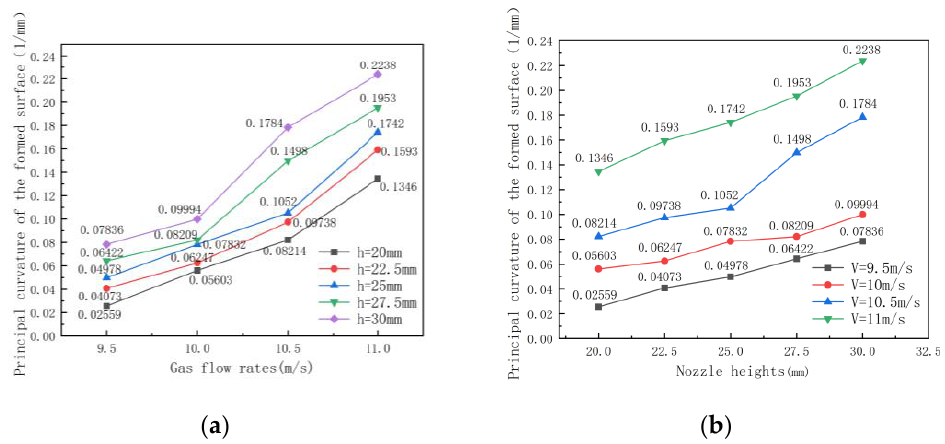
Figure 9. The principal curvature of the formed surface with different gas flow rates and nozzle heights in simulations. ( a ) is the relationship between the gas flow rate and the principal curvature of the formed surface. ( b ) is the relationship between the nozzle height and the principal curvature of the formed surface.